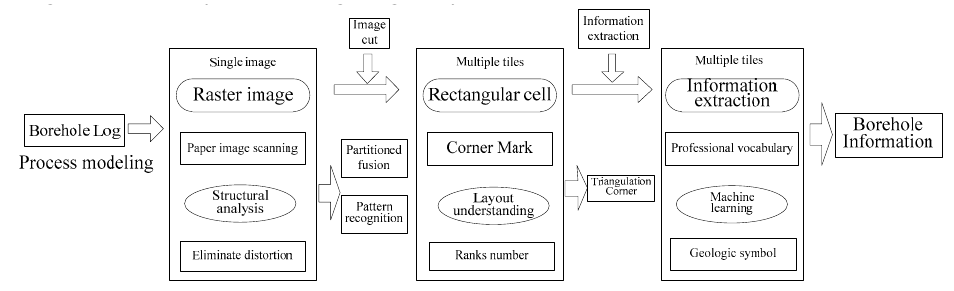
Figure 3 Information extraction process of the borehole log. Figure 3. Information extraction process of the borehole